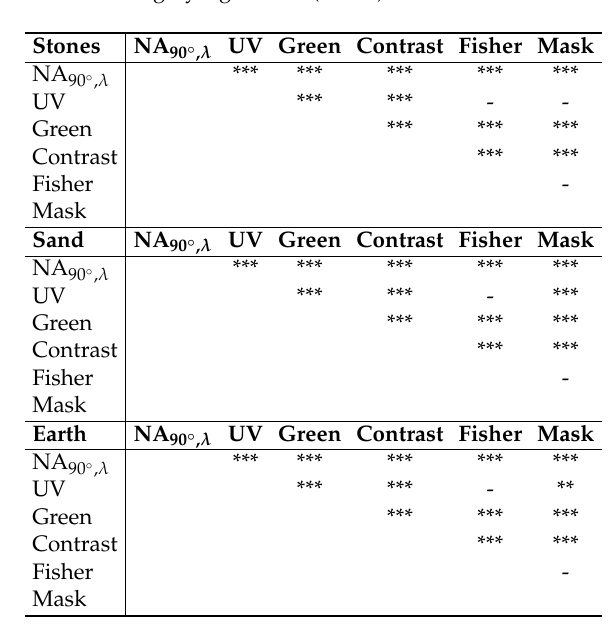
Table 2. Significance tests were performed on all skyline datasets between 7:00 and 20:00 to compare their classification rates. We used bootstrapping [38] as the statistical test; for details, see Section 3.1.1. The shown significance values are 99.9% (***), 99% (**) and 95% (*); for the databases forest/suburban and all, all significance tests are highly significant